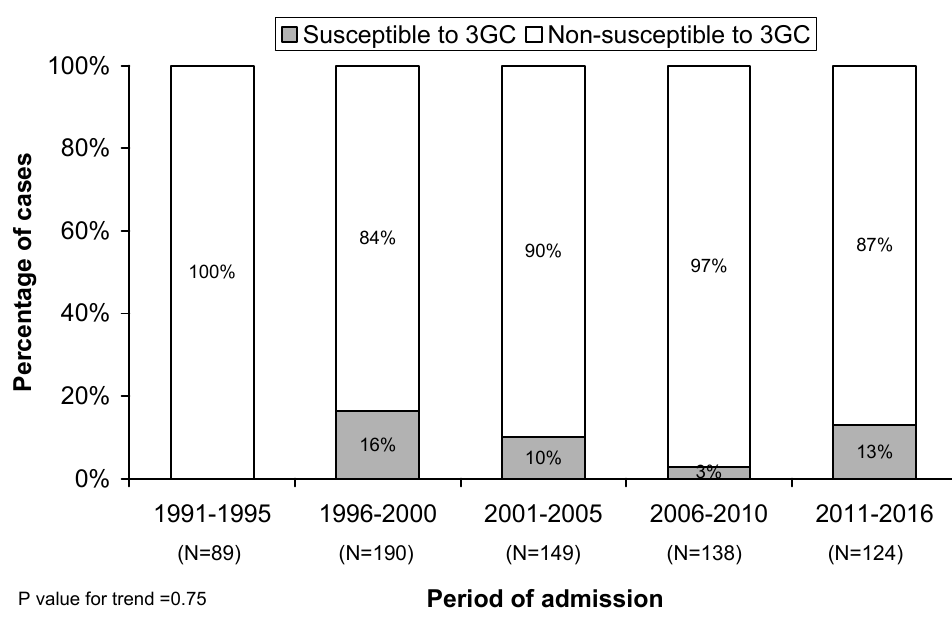
Figure 2. Temporal distribution of susceptible and non-susceptible cefotaxime during the study.